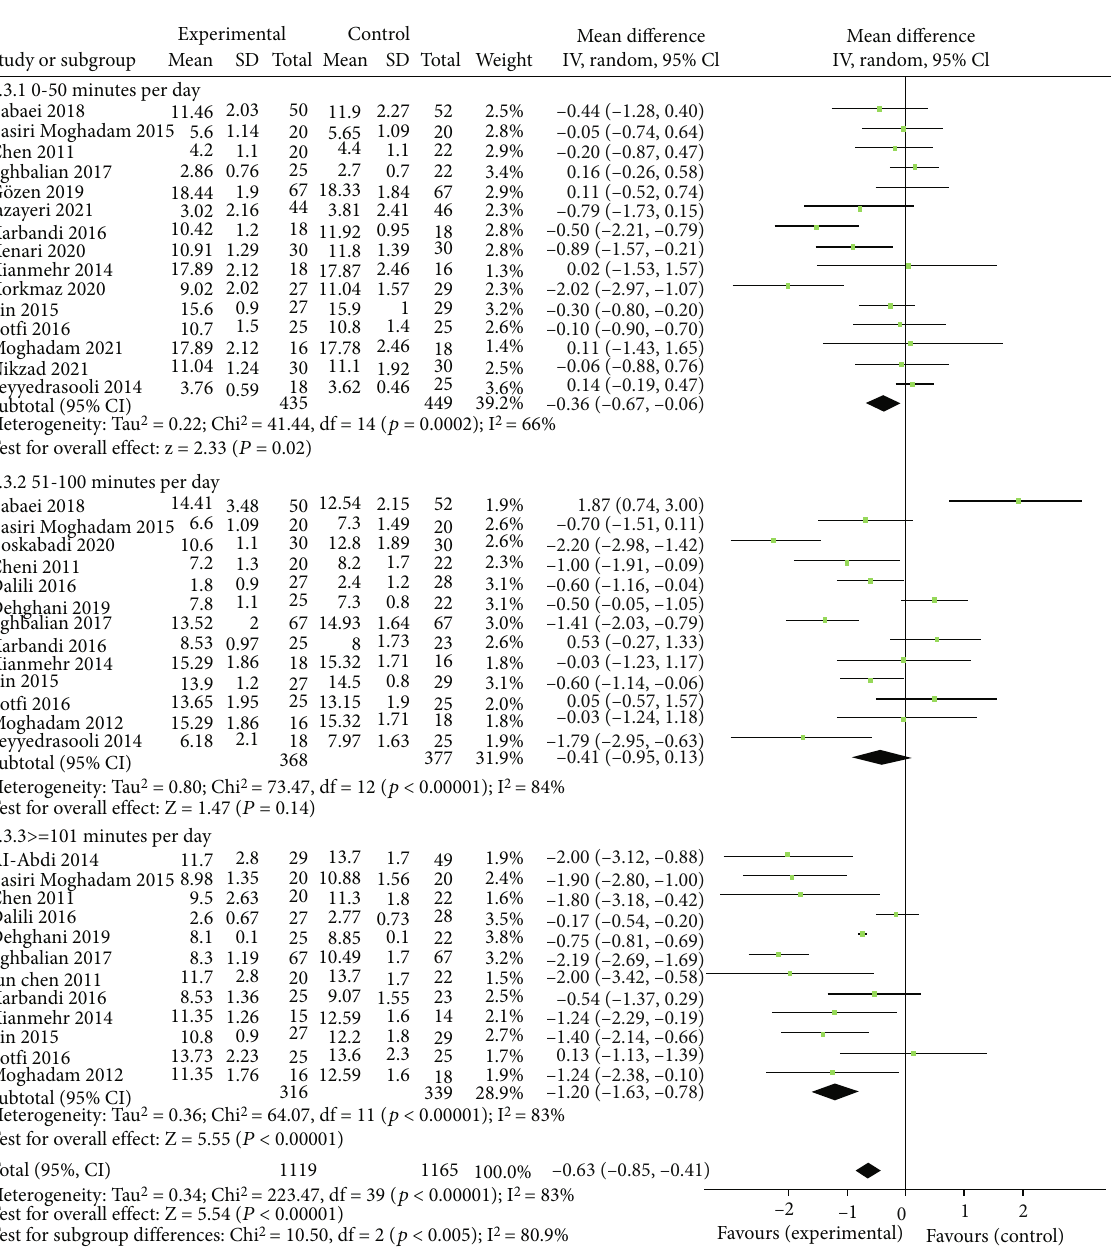
Heterogeneity: Tau 2 = 0.34; Chi 2 = 223.47, df = 39 ( p < 0.00001); I 2 = 83% Test for subgroup differences: Chi 2 = 10.50, df = 2 ( p < 0.005); I 2 = Figure 3: Forest plot of the association between massage therapy and neonatal jaundice in each category of massage